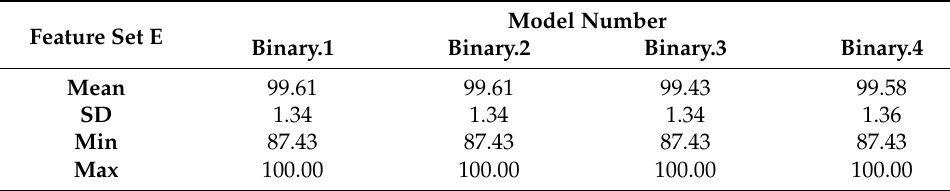
Table 7. A summary of Feature Set E with each model for the binary classification problem, tested using leave-one-out cross-validation. The mean accuracy, standard deviation (SD), minimum and maximum values for each model number are also shown.